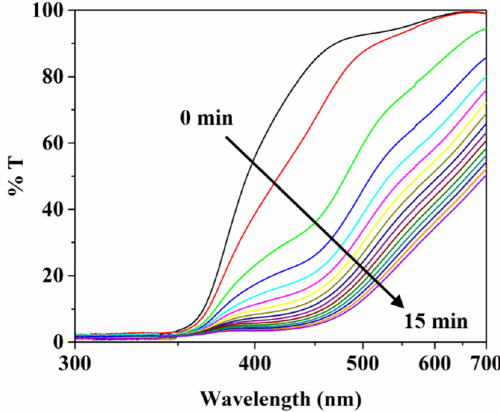
Figure 1. UV–Vis transmittance spectra of the chip showing the plasmonic dip evolution from 0 min to 15 min, using a 10 mM AgNO 3 solution at 20 °C with a flow rate of 1 mL/min. Each spectrum was collected every minute.